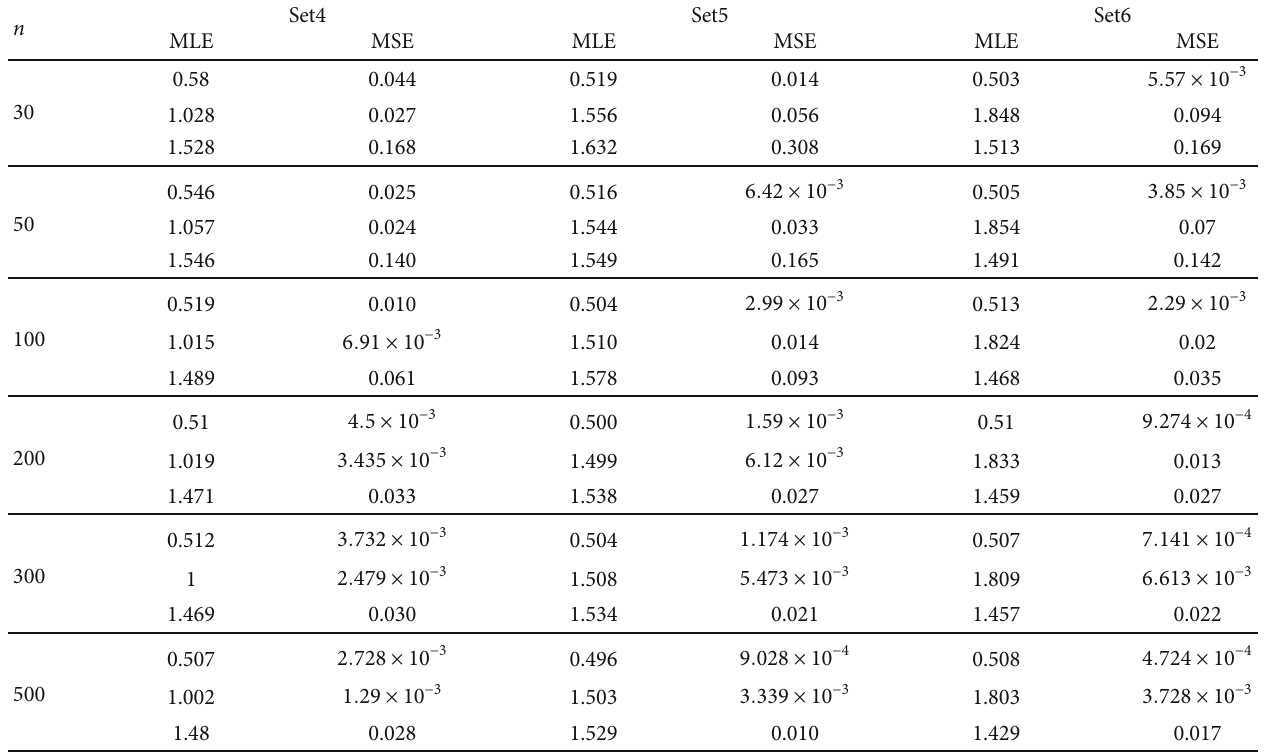
Table 4: The MLEs and MSEs of the APTLL model.